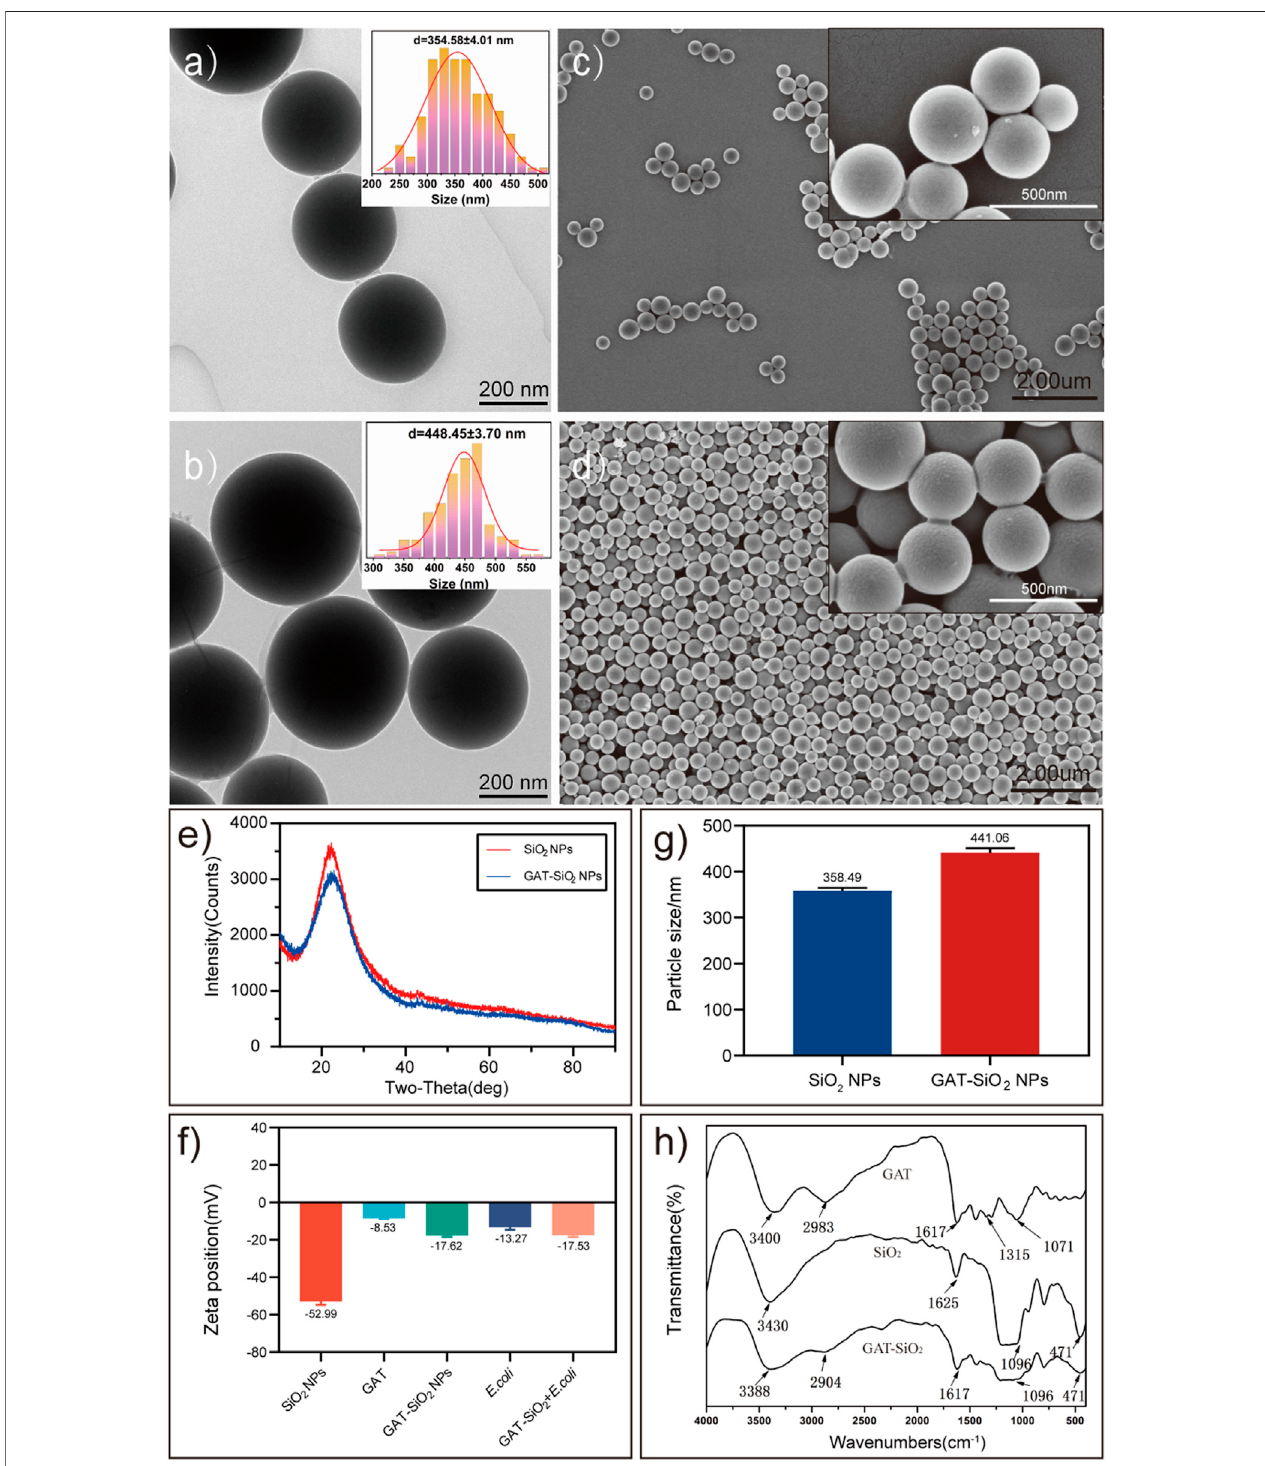
FIGURE 1 | The characteristics of spherical SiO 2 NPs and GAT-SiO 2 NPs. (A,B) TEM image of SiO 2 NPs and GAT-SiO 2 NPs. (C,D) SEM image of SiO 2 NPs and GAT-SiO 2 NPs. (E) XRDpatternofSiO 2 NPsandGAT-SiO 2 NPs. (F) ZetapotentialofSiO 2 NPsandGAT-SiO 2 NPs(mean ± SD; n (cid:1) 3). (G) Theaveragegraindiameterof SiO 2 NPs and GAT-SiO 2 NPs (mean ± SD; n (cid:1) 3). (H) The FT-IR spectra of SiO 2 NPs, GAT, and GAT-SiO 2 NPs.